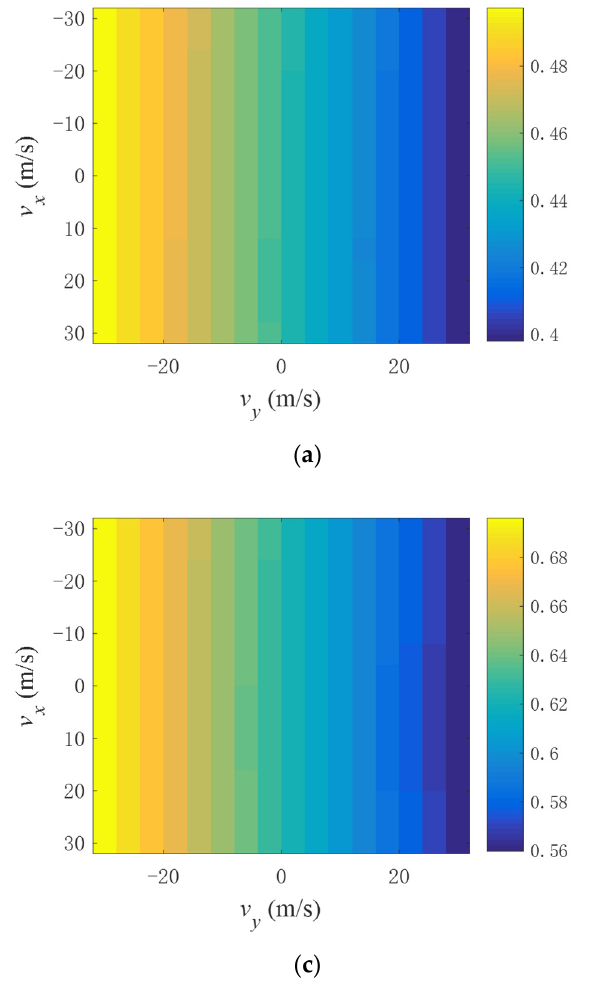
Figure 2. Phase errors under different velocities. ( a ) Proposed range equation, ( b ) second-order Taylor approximated range equation, and ( c ) third-order Taylor approximated range equation. The parameters of the target are: R c = 20 km, a x = 0.3 m/s 2 , and a y = 0.2 m/s 2 .